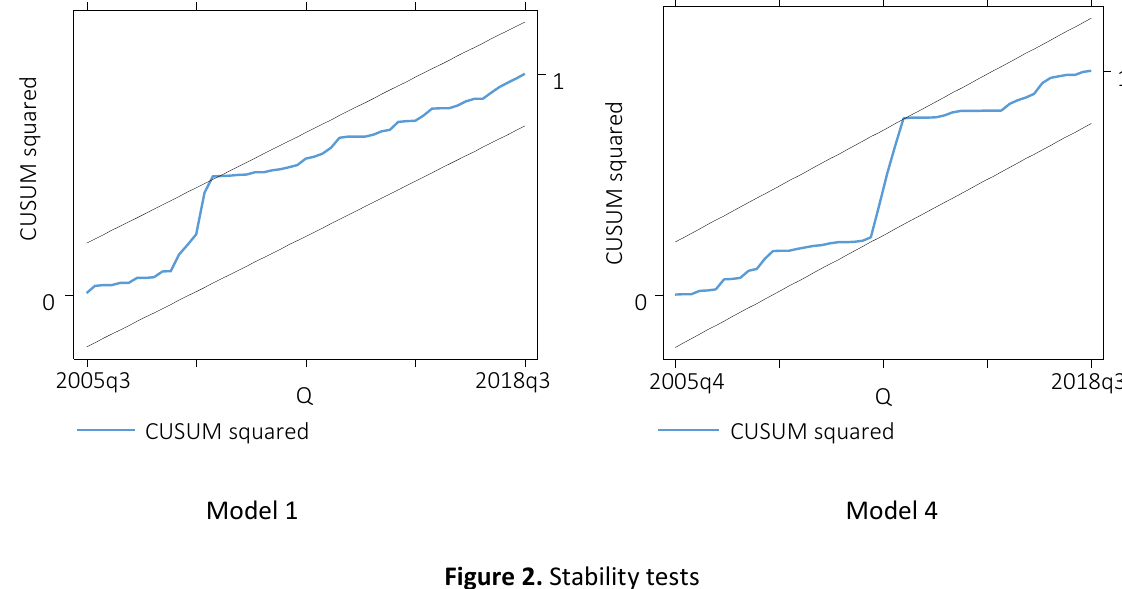
Figure 2. Stability